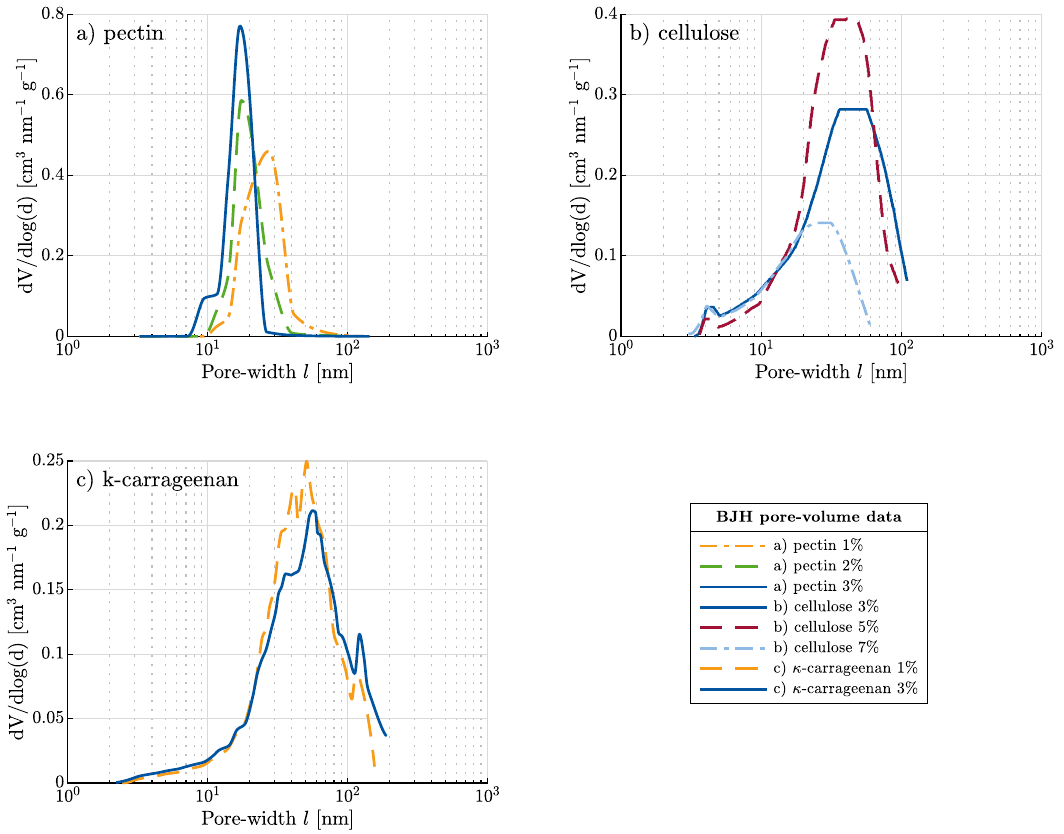
Figure A1. Pore size volume distributions with varying concentrations for three polysaccharide based aerogels: ( a ) pectin, ( b ) cellulose and ( c )